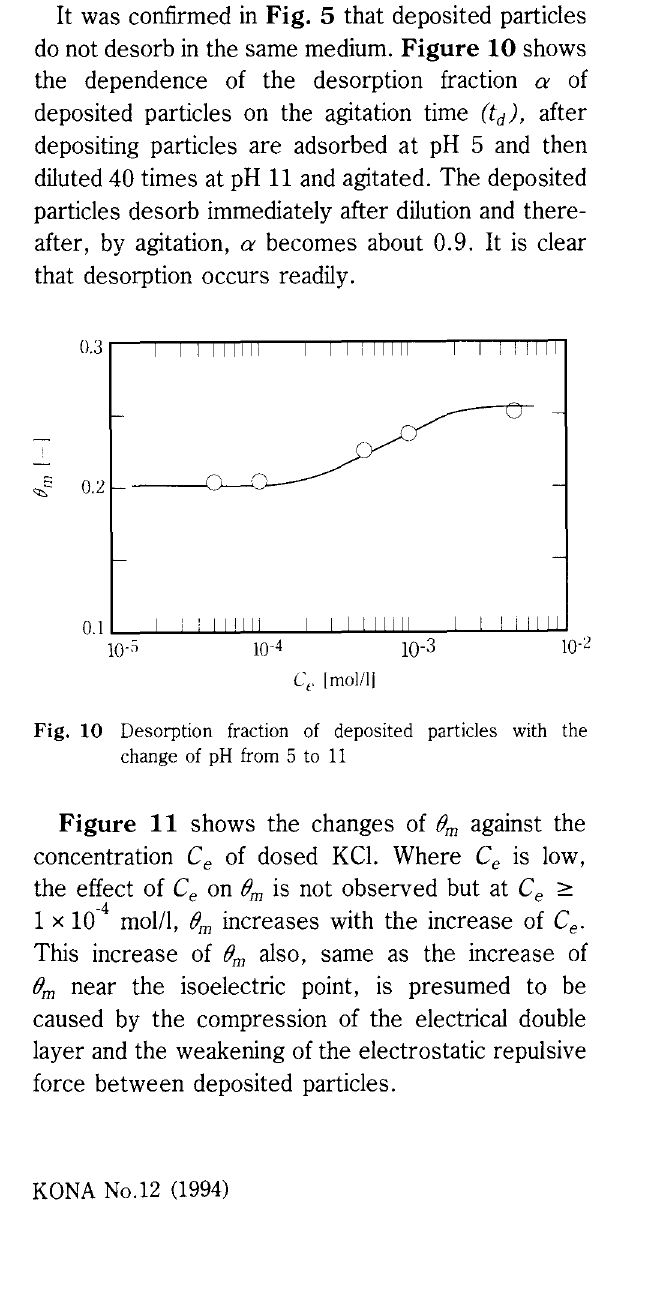
Fig. 9 Schematic drawing of interactions between depositing, deposited and core particles